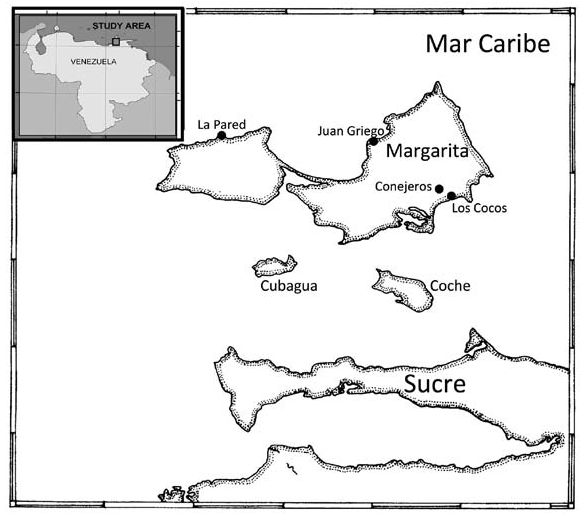
Fig. 1. – Study area and sampling